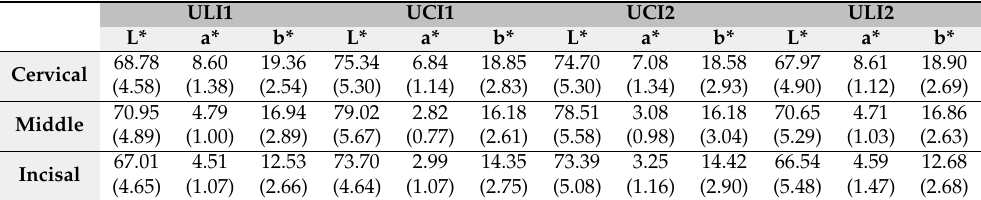
Table 1. CIE-L*a*b* mean values and standard deviations (SD) for each third of the 4 target teeth measured in this